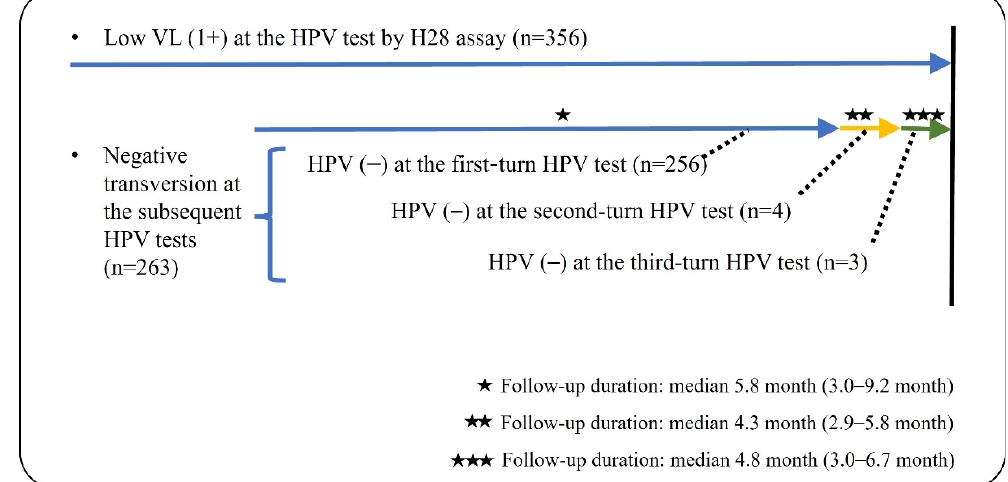
Figure 2. Illustration for clinical follow-ups of low VL (1+) HPV test in this